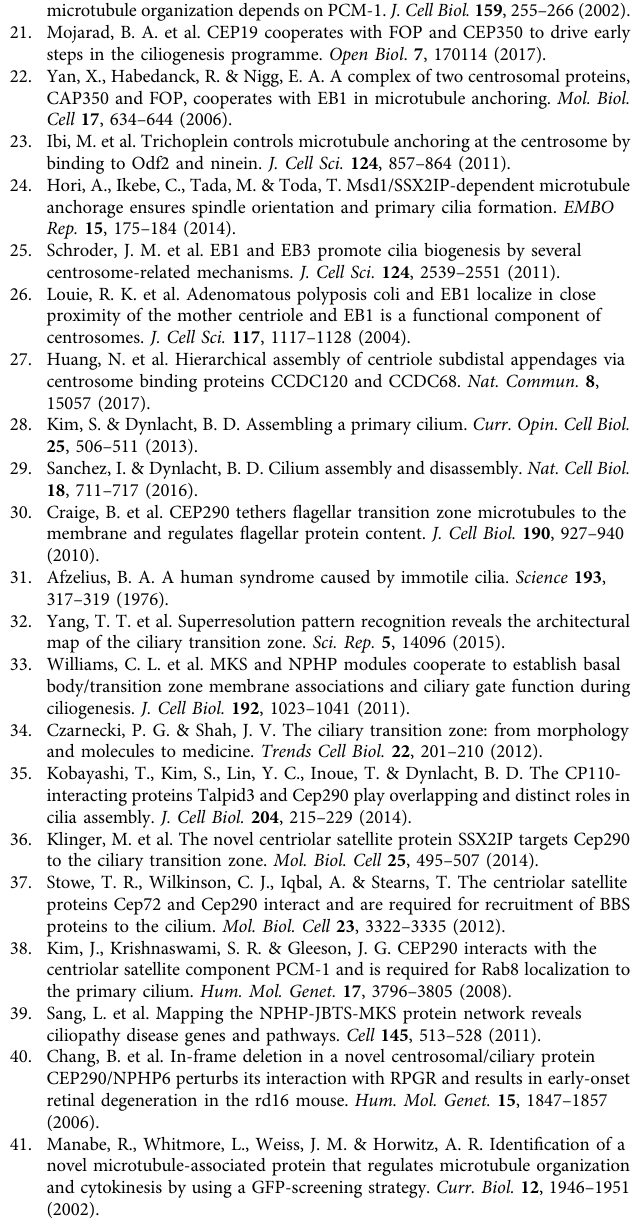
Fig. 8 The microtubule-binding activity of FSD1 is essential for ciliogenesis. a A representative sequence of amino-acid alignment of the FSD1-SPRY domain was shown. The dotted box indicates six conserved arginine residues. b Expression of GFP-FSD1 WT, but not FSD1 3RE (R332E, R335E, and R337E) mutant, induced microtubule bundles. Scale bars, 5 μ m (main image) and 1 μ m (magni fi ed region). c Mutation of three conserved arginine residues to glutamic acid (R332E, R335E, and R337E) abolishes the microtubule-binding activity of FSD1-SPRY domain. Puri fi ed FSD1-SPRY-WT, but not FSD1-SPRY-3RE, was co- pelleted with Taxol-stabilized microtubules. d Expression of GFP-FSD1 WT, but not 3RE mutant, rescued MT aster formation defects caused by FSD1 depletion. RPE-1 cells transfected with indicated siRNA and plasmids were subjected to a microtubule regrowth assay after nocodazole release 20 min. e Expression of GFP-FSD1 WT, but not 3RE mutant, rescued ciliogenesis defects caused by FSD1 depletion in quiescent cells. f Expression of GFP-FSD1 WT, but not 3RE mutant, rescued Cep290 localization at centriolar satellites in cycling cells. g Expression of GFP-FSD1 WT, but not 3RE mutant, rescued TMEM67 localization at centrioles in quiescent cells. h Expression of GFP-FSD1 WT, but not 3RE mutant, rescued NPHP8 localization at centrioles in quiescent cells. i Model of MT aster promoting ciliary transition zone assembly. FSD1 and other subdistal appendage proteins, such as Ninein, Kif3a, facilitate the formation of MT asters by anchoring MTs at the mother centriole. MT asters keep Cep290 at the centriolar satellites and promote transition zone assembly during ciliogenesis. MC mother centriole, MT microtubule, TZ transition zone, CV ciliary vesicle. Data are presented as mean ± s.d. of three independent experiments. n number of cells. In all panels, statistical comparisons between two groups were carried out by two-tailed t -test. ** P < 0.01, *** P <